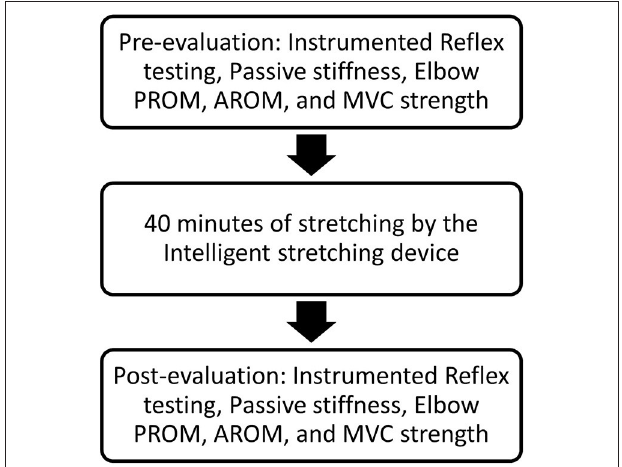
FIGURE 1 | Representation of the flow of the experimental procedure. PROM, passive range of motion; AROM, active range of motion; MVC, maximum voluntary